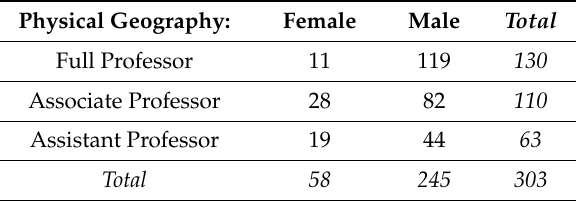
Table 2. Gender-based representation of faculty in physical geography at Canadian university geography departments.